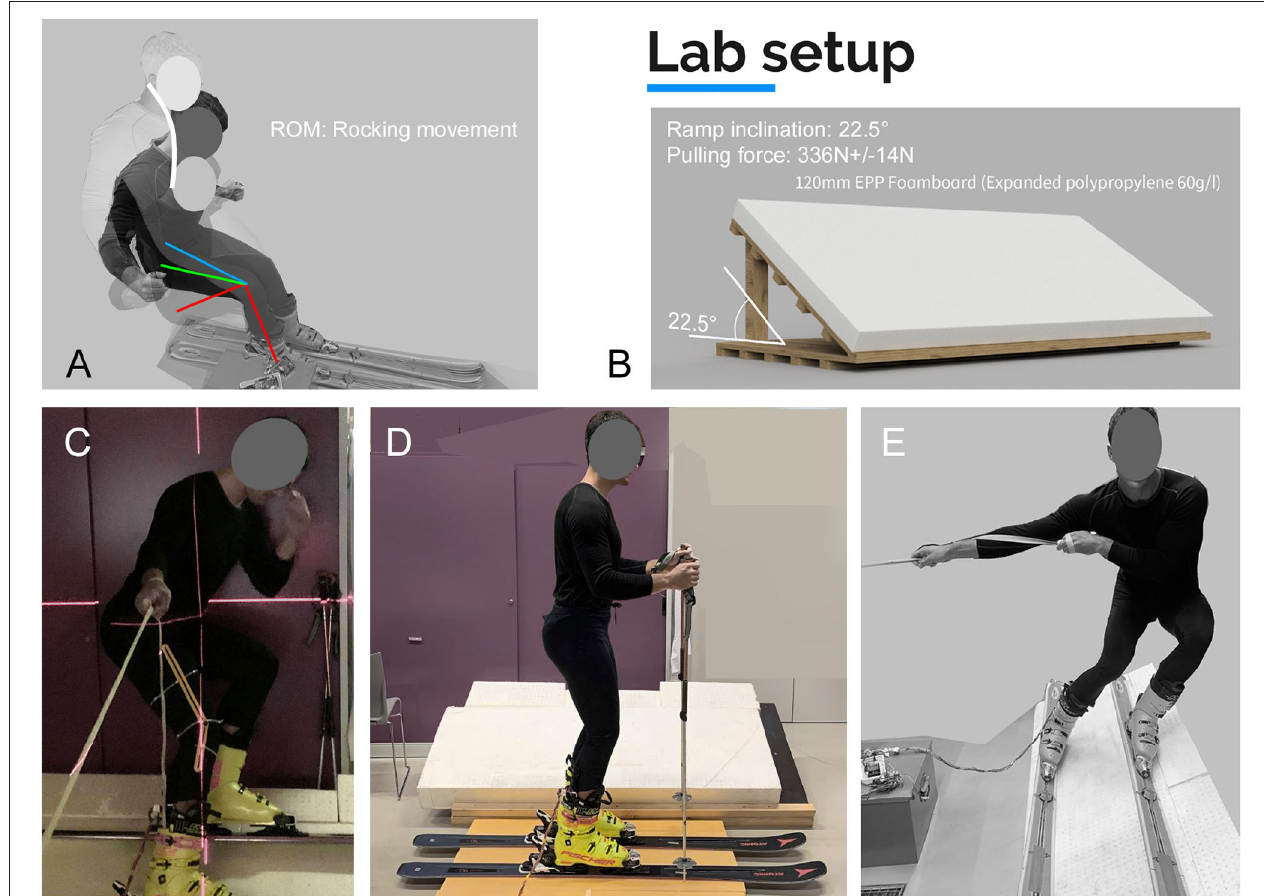
FIGURE 3 | Lab experimental setup: (A) ROM at lay back movement, (B) Ramp setup, (C) Measuring of body angles using laser level and protractor. (D) Tare position, (E) Body position while pulling up the resistance weight in central stance.